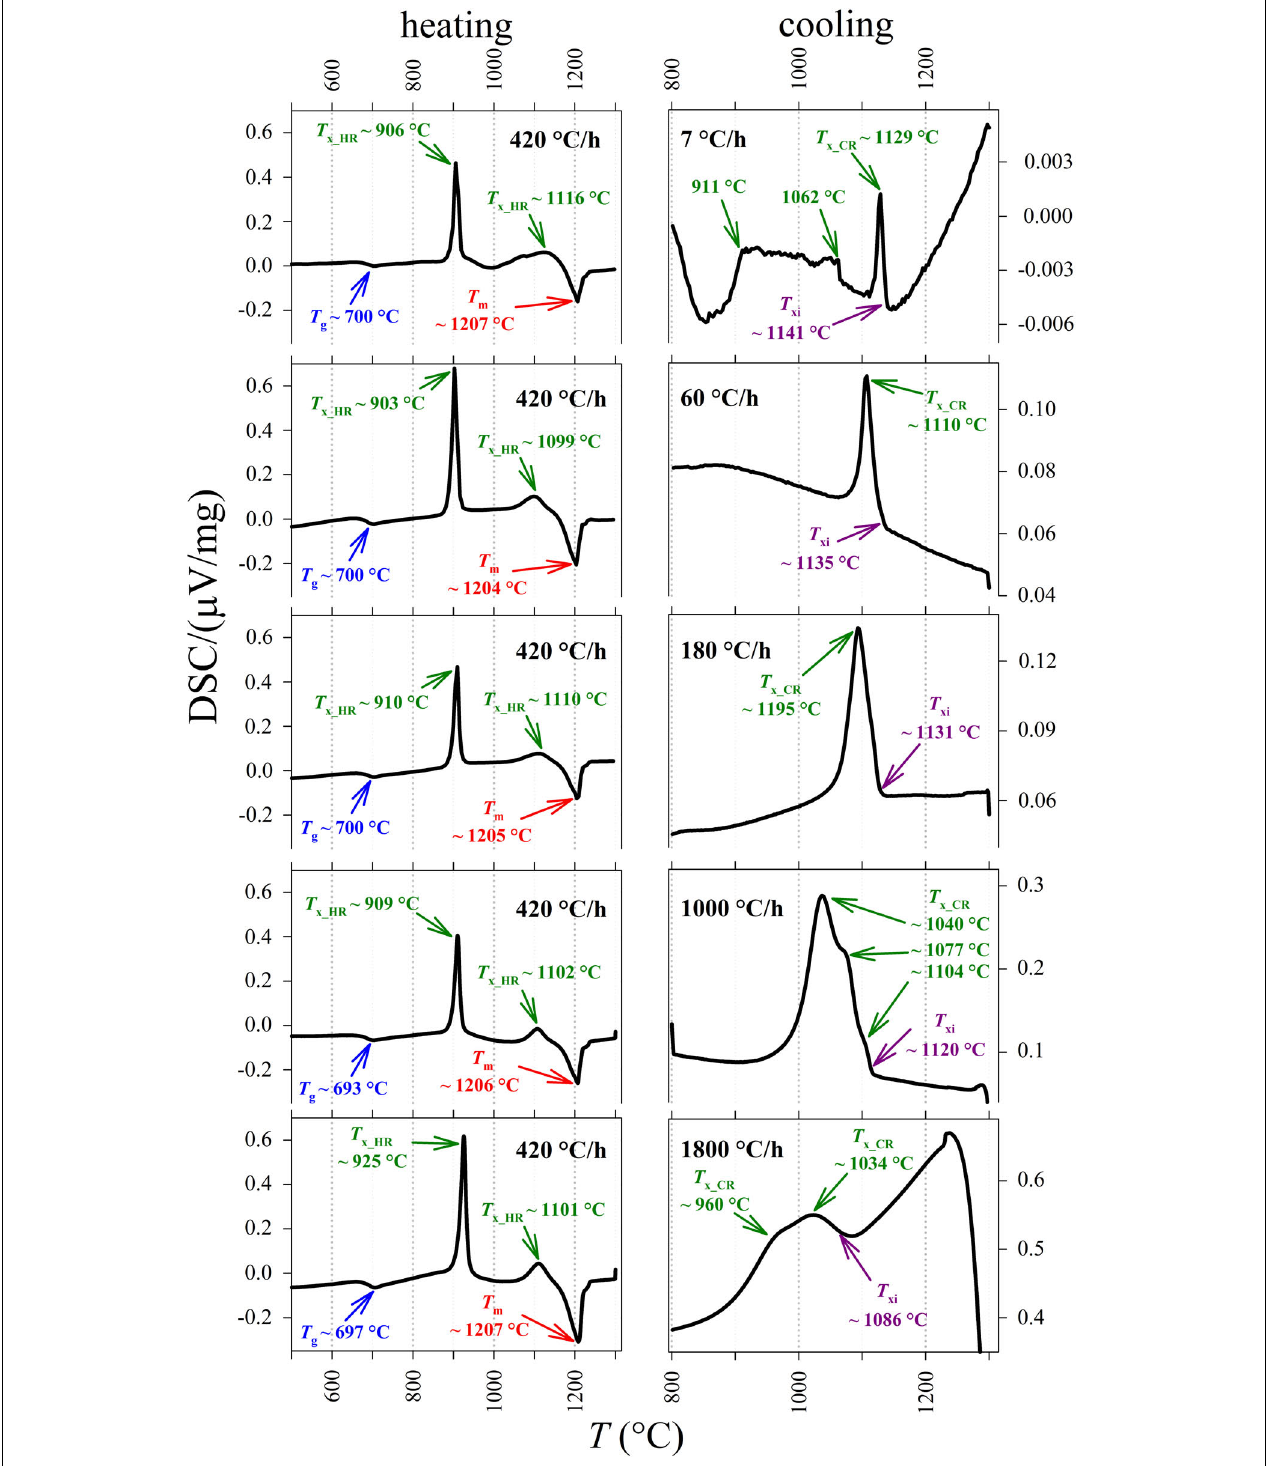
FIGURE 1 | DSC spectra for the basaltic melt, relating the DSC signal based on the differential heat flux (DSC/( µ V/mg)) and T ( ◦ C). On the left: heating treatment from ambient temperature to 1300 ◦ C at 420 ◦ C/h. On the right and from top to bottom: cooling rate paths at 7, 60, 180, 1000, and 1800 ◦ C/h, respectively. Glass transition temperature ( T g ), crystallization temperature ( T x_HR ) and melting temperature ( T m ) were measured by in situ DSC spectra acquired on heating. T x was also measured along the cooling path of the melt ( T x_CR ). The temperature of the onset of crystallization ( T xi ) has been computed at 10% of the maximum intensity of the crystallization